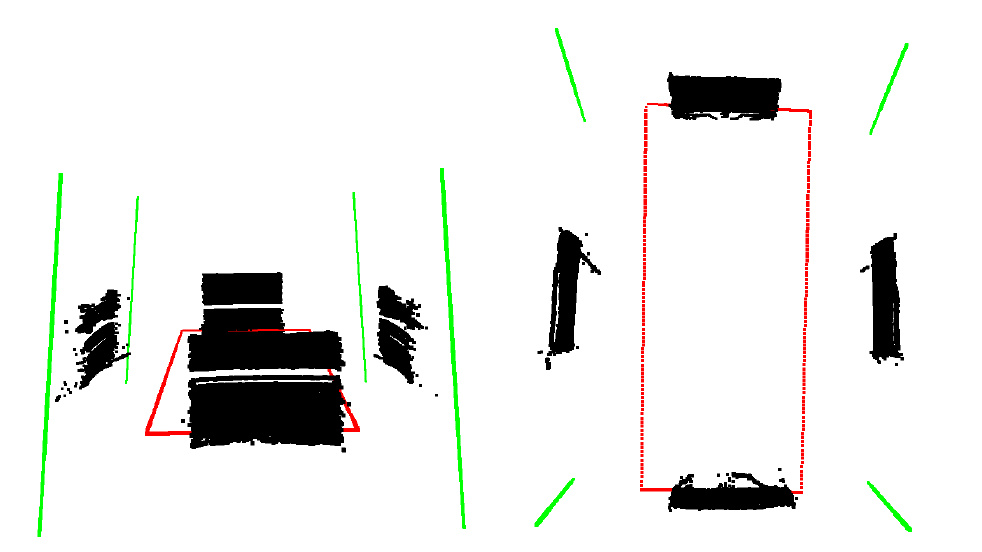
Figure 9. Calibration of the car’s bounding box. The black points are measured by a LiDAR device, and the green and red lines indicate the intersection of the detected planes and the bounding box of the car,